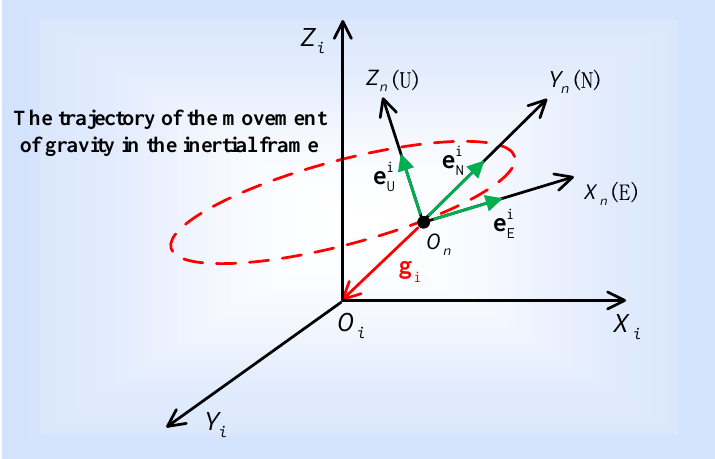
Figure 2. The relation between the i-frame and the n-frame by using the gravity vector.